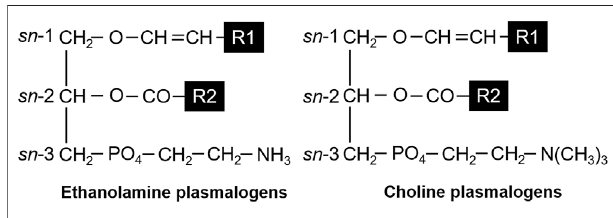
FIGURE 1 | Structures of ethanolamine plasmalogens (PlsEtn) and cholineplasmalogens(PlsCho). R1and R2denote thecarbon chainat the sn - 1 and sn -2 positions,